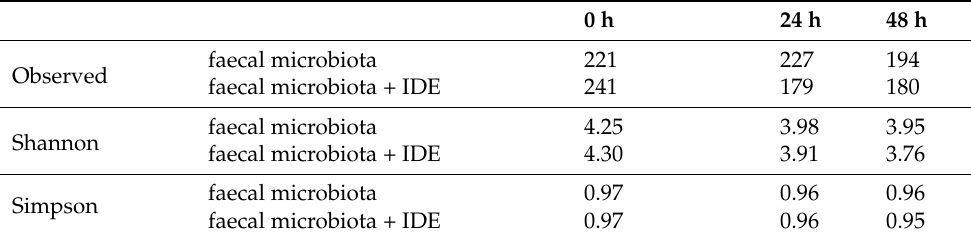
Table 2. The evolution of alpha diversity during faecal fermentation in the absence or presence of the intestinal-digested extract (IDE).